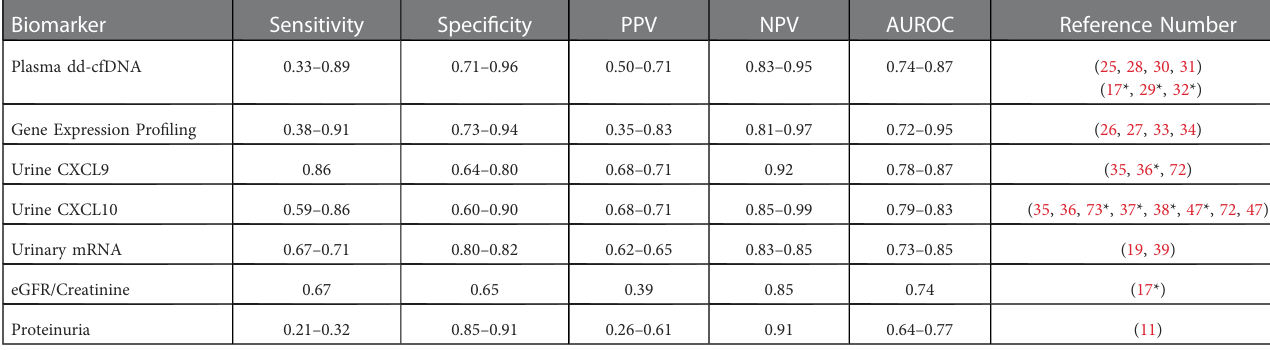
TABLE 2 Summary of performance metrics for select biomarkers in kidney transplantation. Many of the novel biomarkers discussed in this review are presented below with a range of data on performance metrics from multiple studies in kidney transplant recipients, with corresponding references in the far right column. Similar data on clinical standards eGFR and proteinuria are presented at the bottom for comparison.